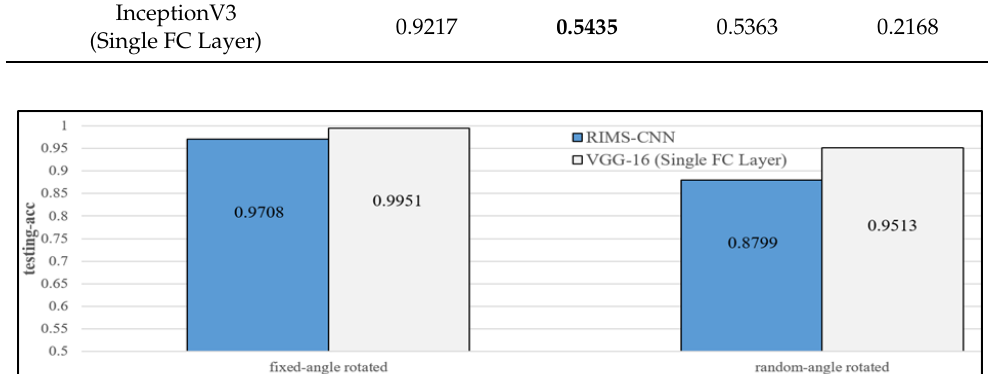
Figure 28. Evaluating RIMS-CNN and VGG-16 on the fixed-angle and random-angle rotated MNIST.